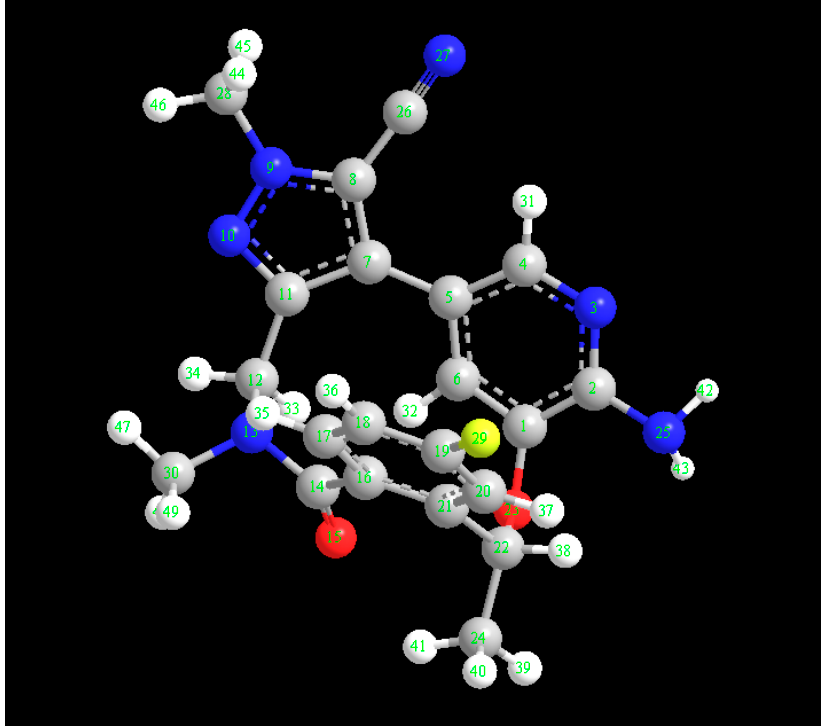
Figure 5. The energy minimized LOR molecule with atom numbers, and arrow points to atom wit the highest electron density (N25) which participated in CTC formation between LOR and DDQ. Table 3. Atom numbers, types, and their calculated charges on the energy minimized LOR